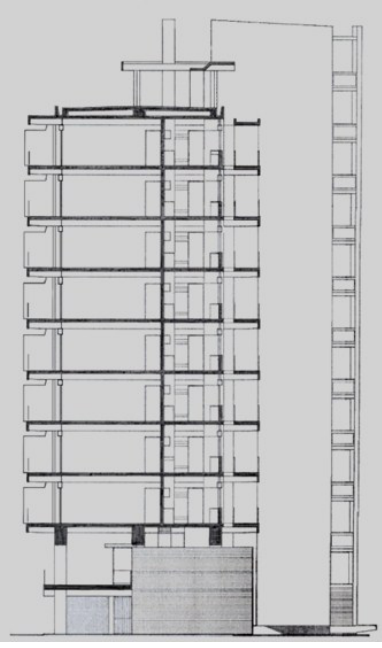
Figure 6. Section.